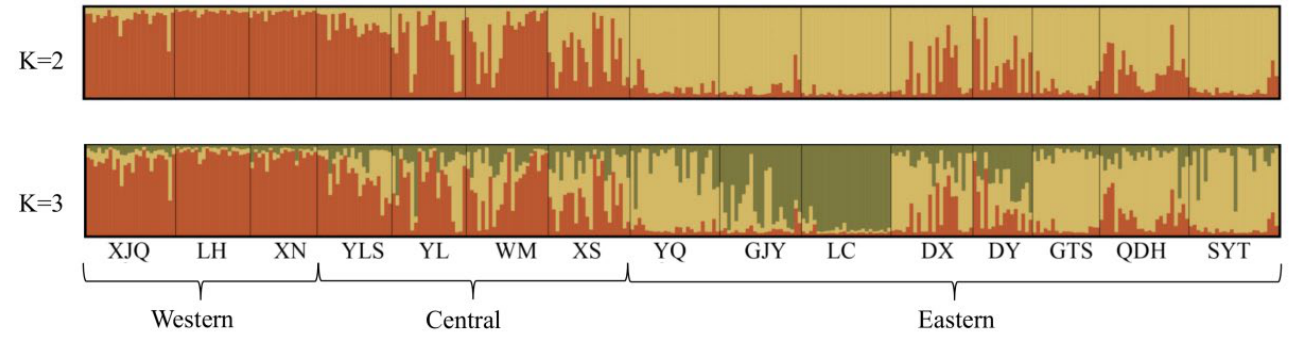
Figure 2. Bayesian clustering analysis of Castanopsis sclerophylla based on nuclear microsatellite markers. Table 5. Analysis of molecular variance of Castanopsis sclerophylla based on nuclear SSRs.